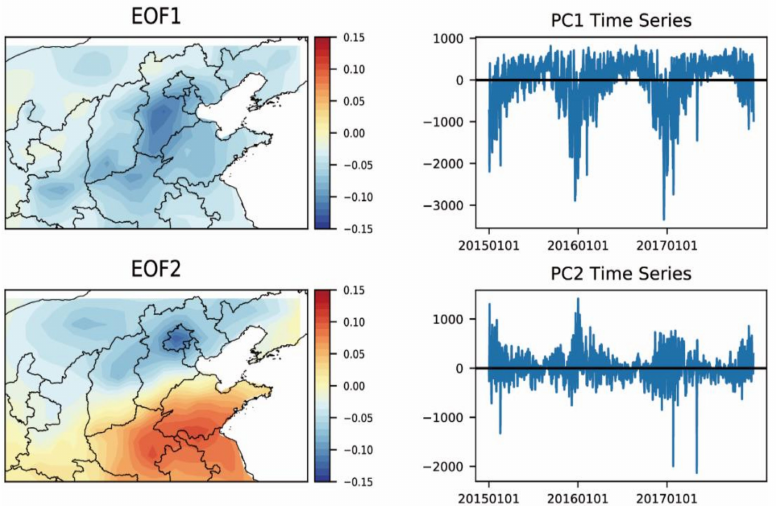
Figure 2. The EOF analysis of PM 2.5 concentration in Northern China. The left column depicts the first and second modes of EOF, and the right column depicts the corresponding PC sequences.